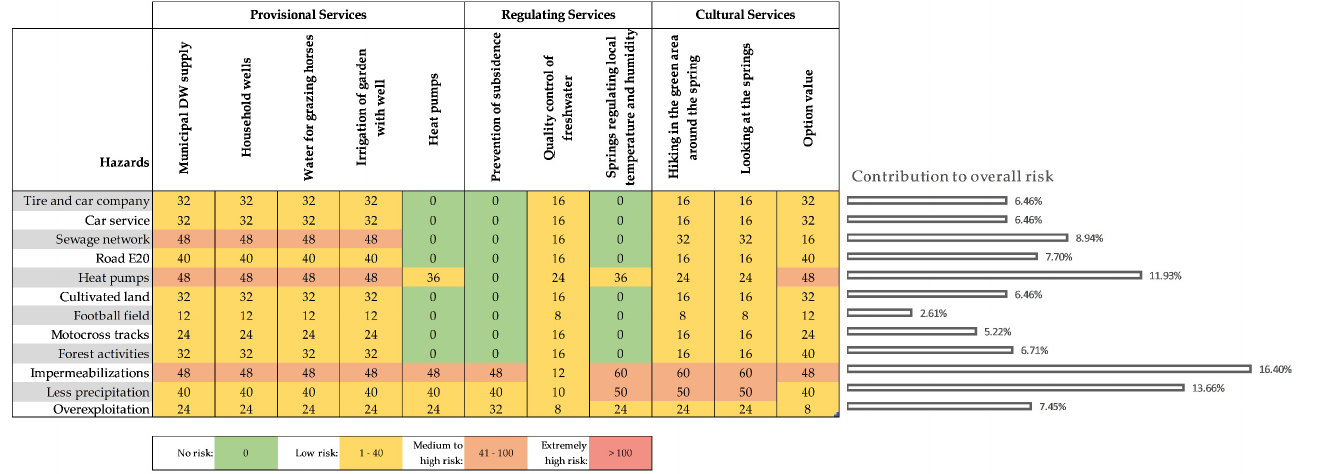
Figure 6. Identified hazard sources that pose a risk to the municipal drinking water supply.